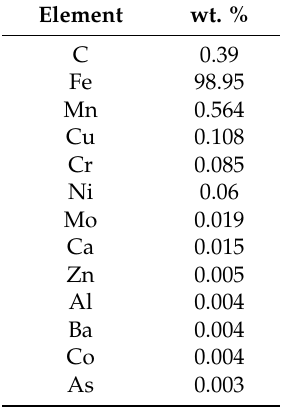
Table 1. Elemental composition of the reference steel sample used in this study.